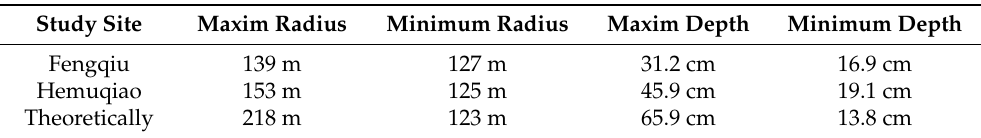
Table 1. The footprint of the CRNS simulated by URANOS at different study sites. The theoretical values of the detection radius and detection depth were obtained from simulation results under extremely dry and extremely humid conditions. Study Site Maxim Radius Minimum Radius Maxim Depth Minimum Depth Fengqiu 139 m Hemuqiao 153 m